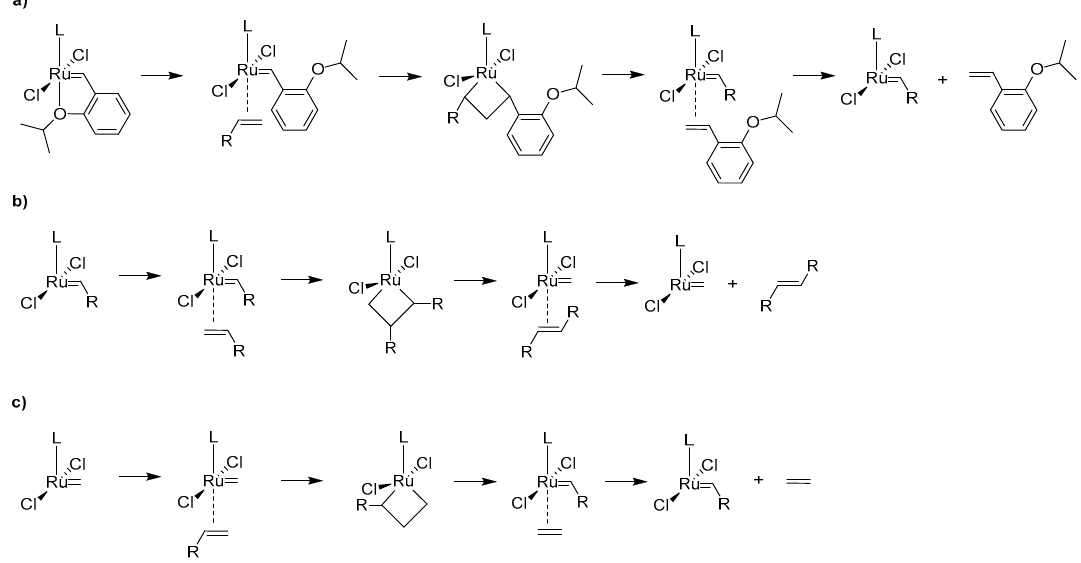
Figure 2. Schematic representation of the metathesis catalytic cycle; ( a ) initiation, ( b , c ) propagation.